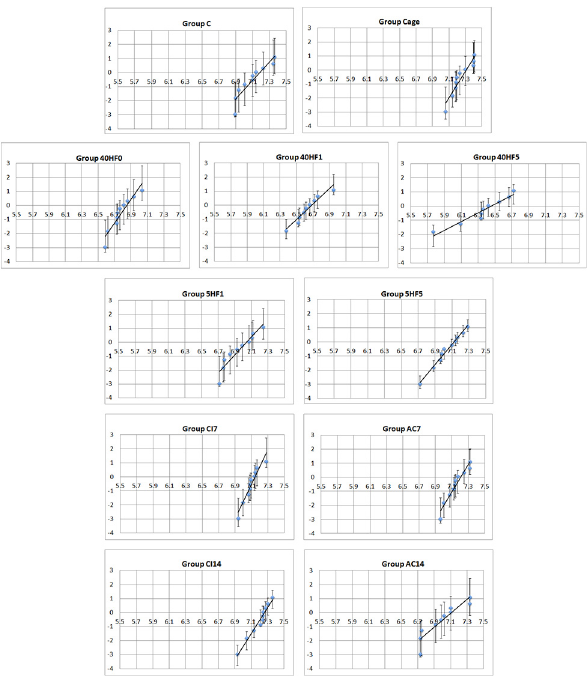
Fig 1. Weibull plots for all the experimental groups with 95% confidence